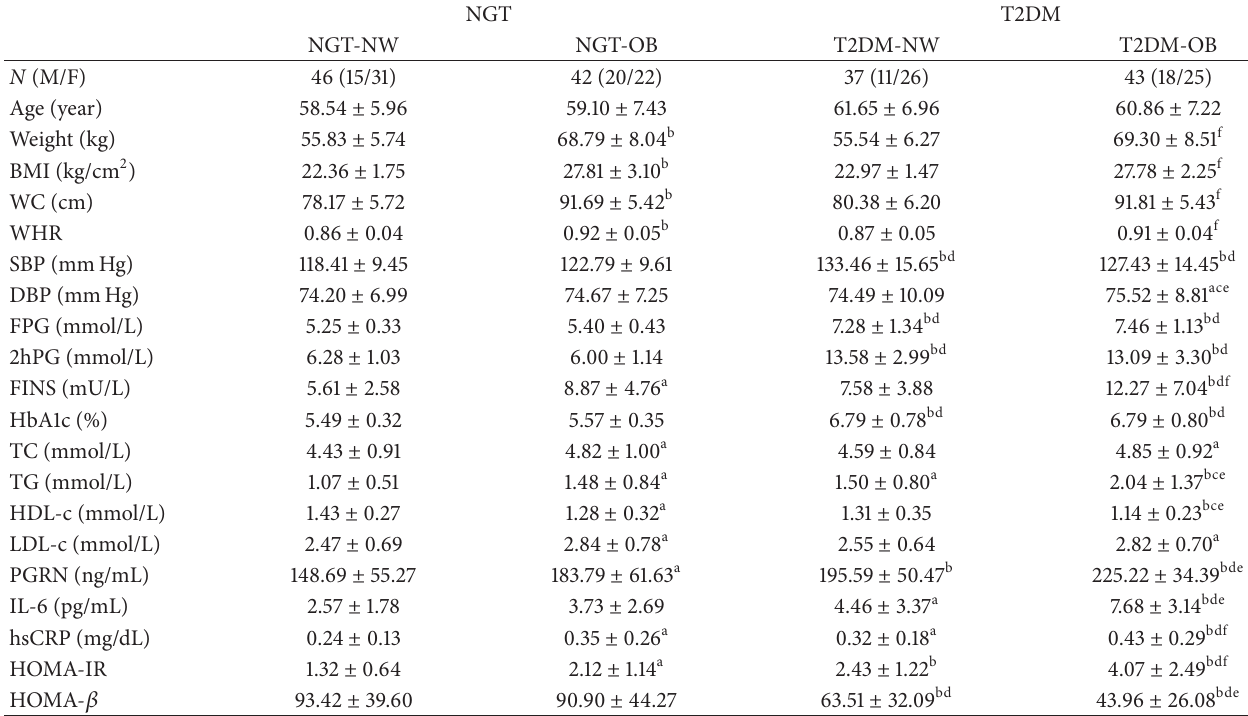
Table 1: Anthropometric and metabolic characteristics of the study groups.